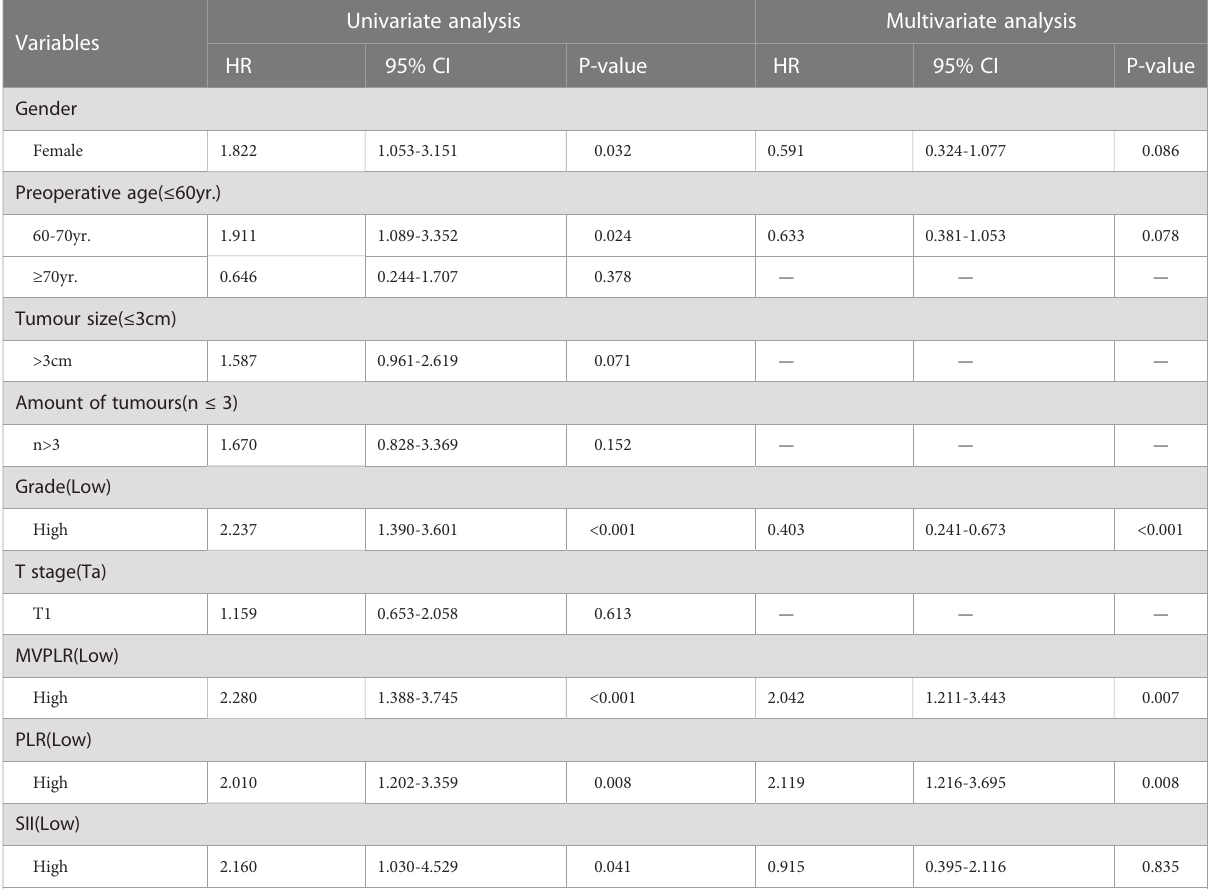
TABLE 4 Univariate and multivariate analysis with a Cox proportional hazard model of risk factors on RFS of the patients treated with intravesical GEM.